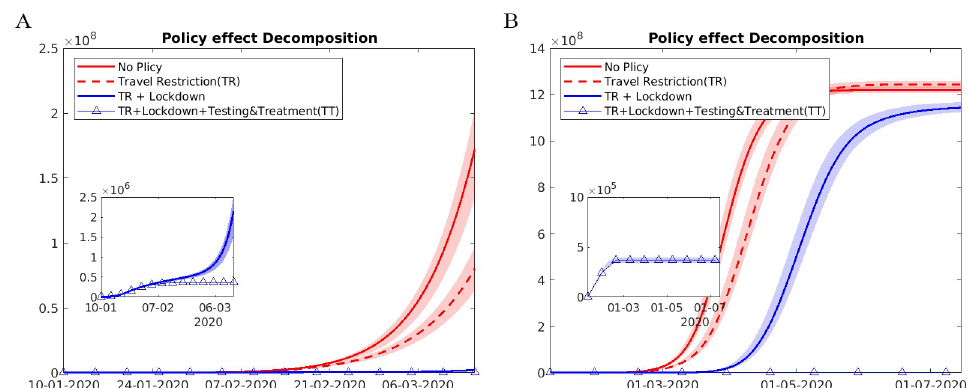
Fig 7. Alternative scenarios: Lifting combinations of different policies. This figure plots the trends in observed and counterfactual number of cumulative infections under several alternative scenarios from (A) Jan 1,2020 to Mar 15,2020, and from (B) Jan 1 to July 15. Data are presented as the median (solid line) and IQR (shading) of estimates (200 simulations). “No Policy” denotes the scenario in which no anti-contagion policies have been put in place. “Travel Restriction” denotes the case where only intercity travel bans were implemented after January 23. “TR+Lockdown” denotes the scenario in which both intercity travel restrictions and city lockdown were implemented. “TR+Lockdown +Testing&Treatment(TT)” denotes the baseline scenario in which all three policies have been implemented from January 23 to March 15.